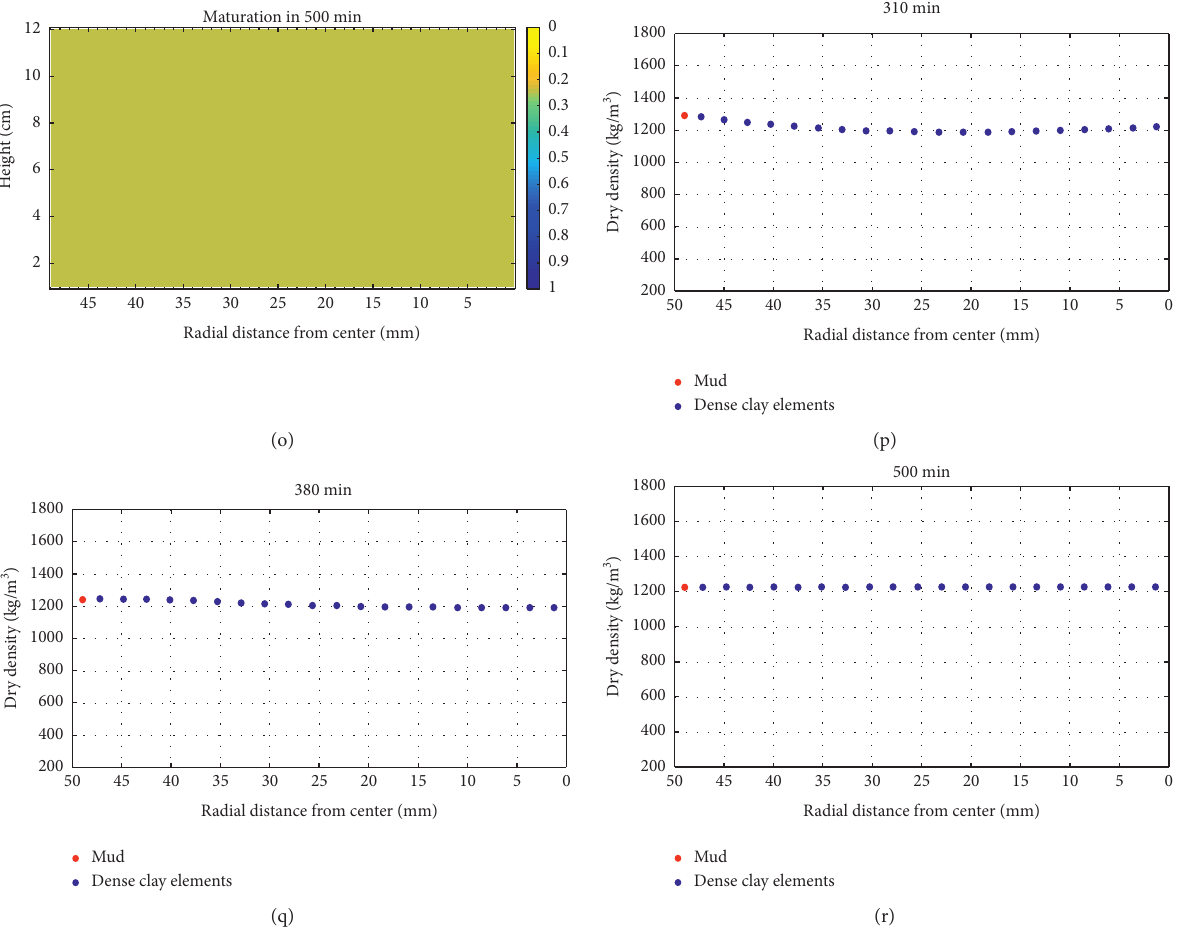
Figure 9: Simulated maturation process of the clay seals. (a, b, c, g, h, i, m, n, o) The water transport in clay as a function of maturation time. (d, e, f, j, k l, p, q, r) The clay migration, presenting density changes of different parts of the clay seal as a function of